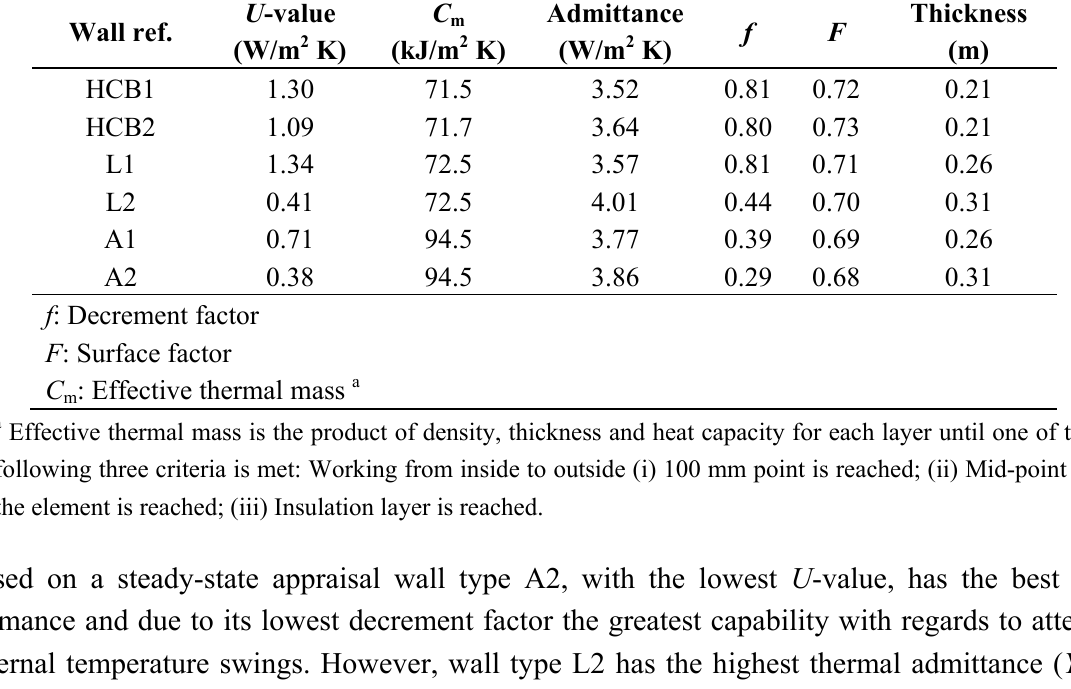
Table 4. Thermal properties including derived parameters for each wall type. Wall